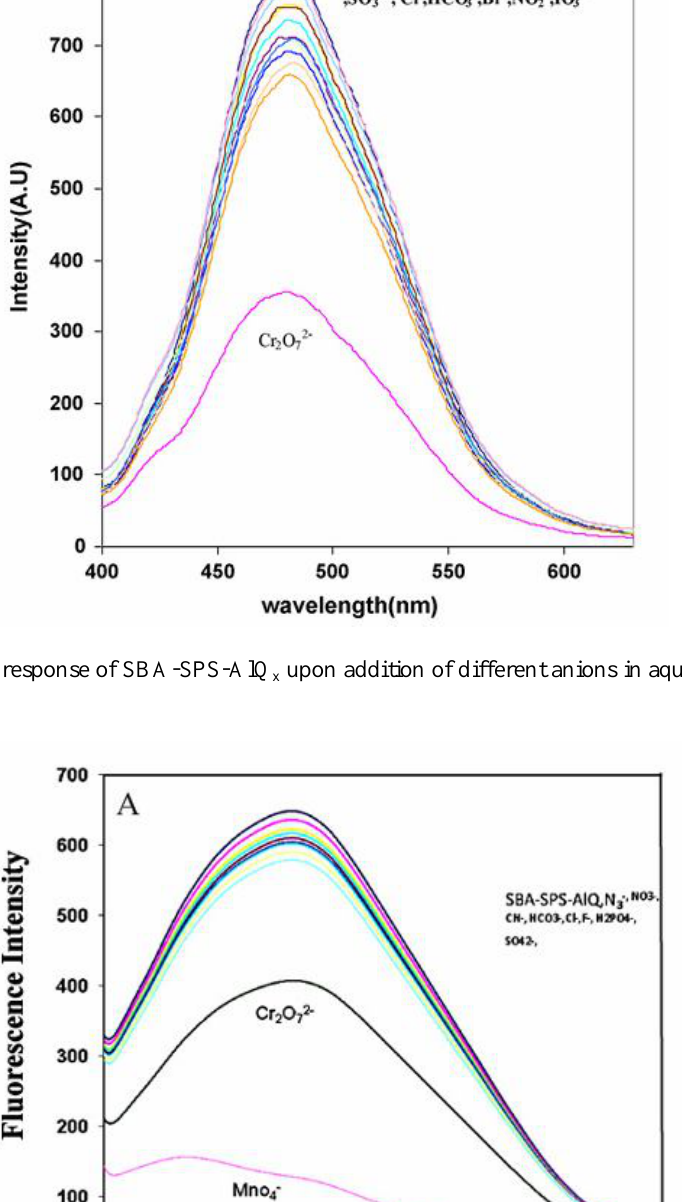
in the presence of various anions x